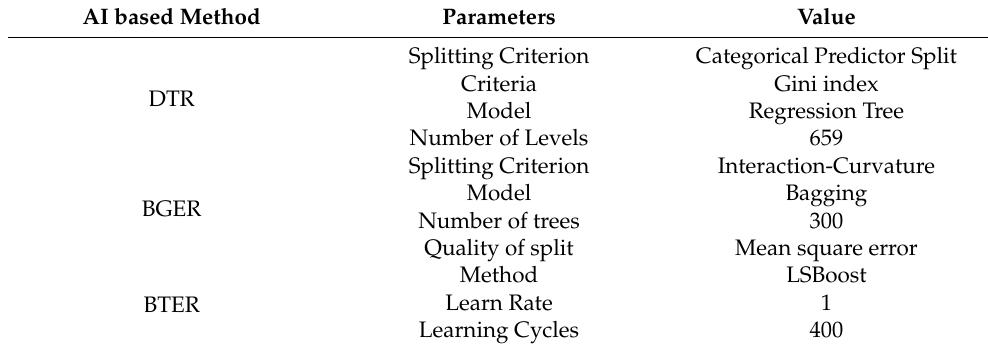
Table 1. Training parameters